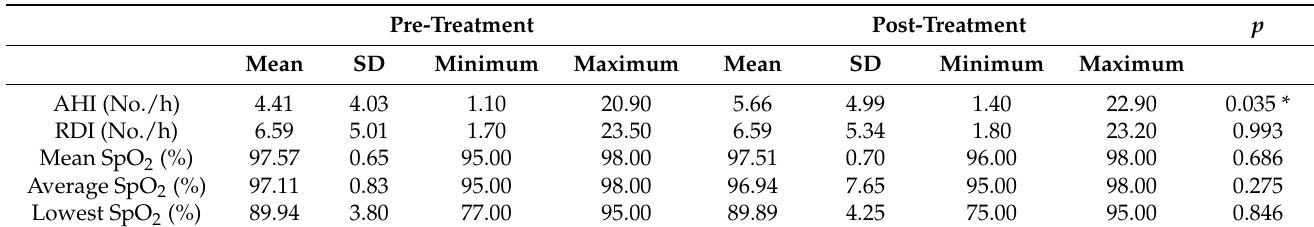
Table 4. Pre- and post-treatment polysomnographic measures in the non-responsive group.